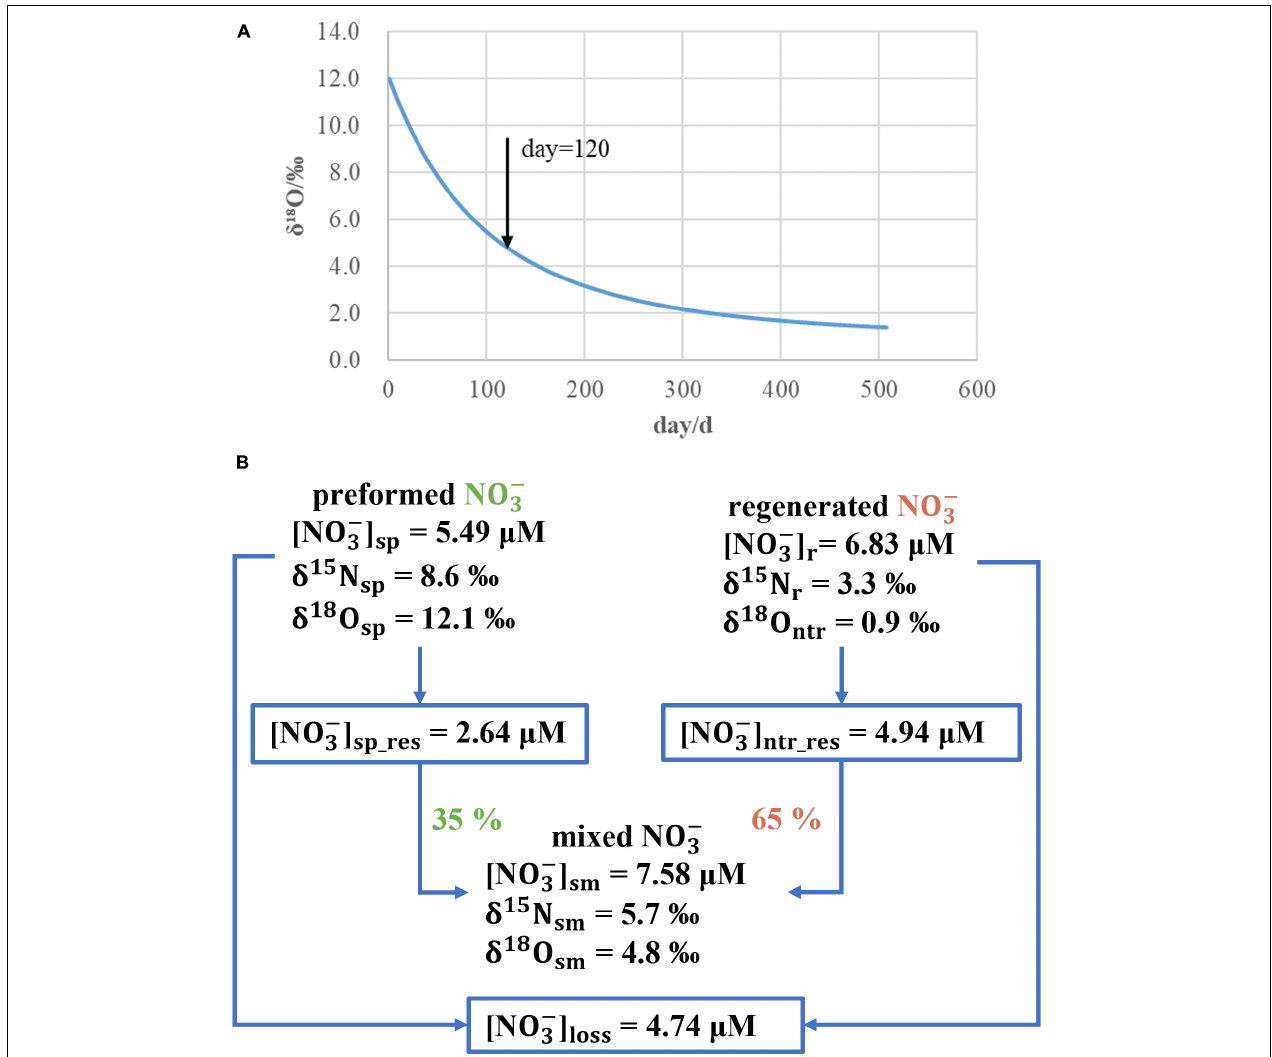
FIGURE 6 | Simulation results of the mixing model for the sCW: δ 18 O-NO − 3 decreases along with simulation time when δ 18 O ntr is set to 0.9 diagram of the mixing model, in which the sCW nitrate pool consists of 35% preformed and 65% regenerated nitrate in summer (B)